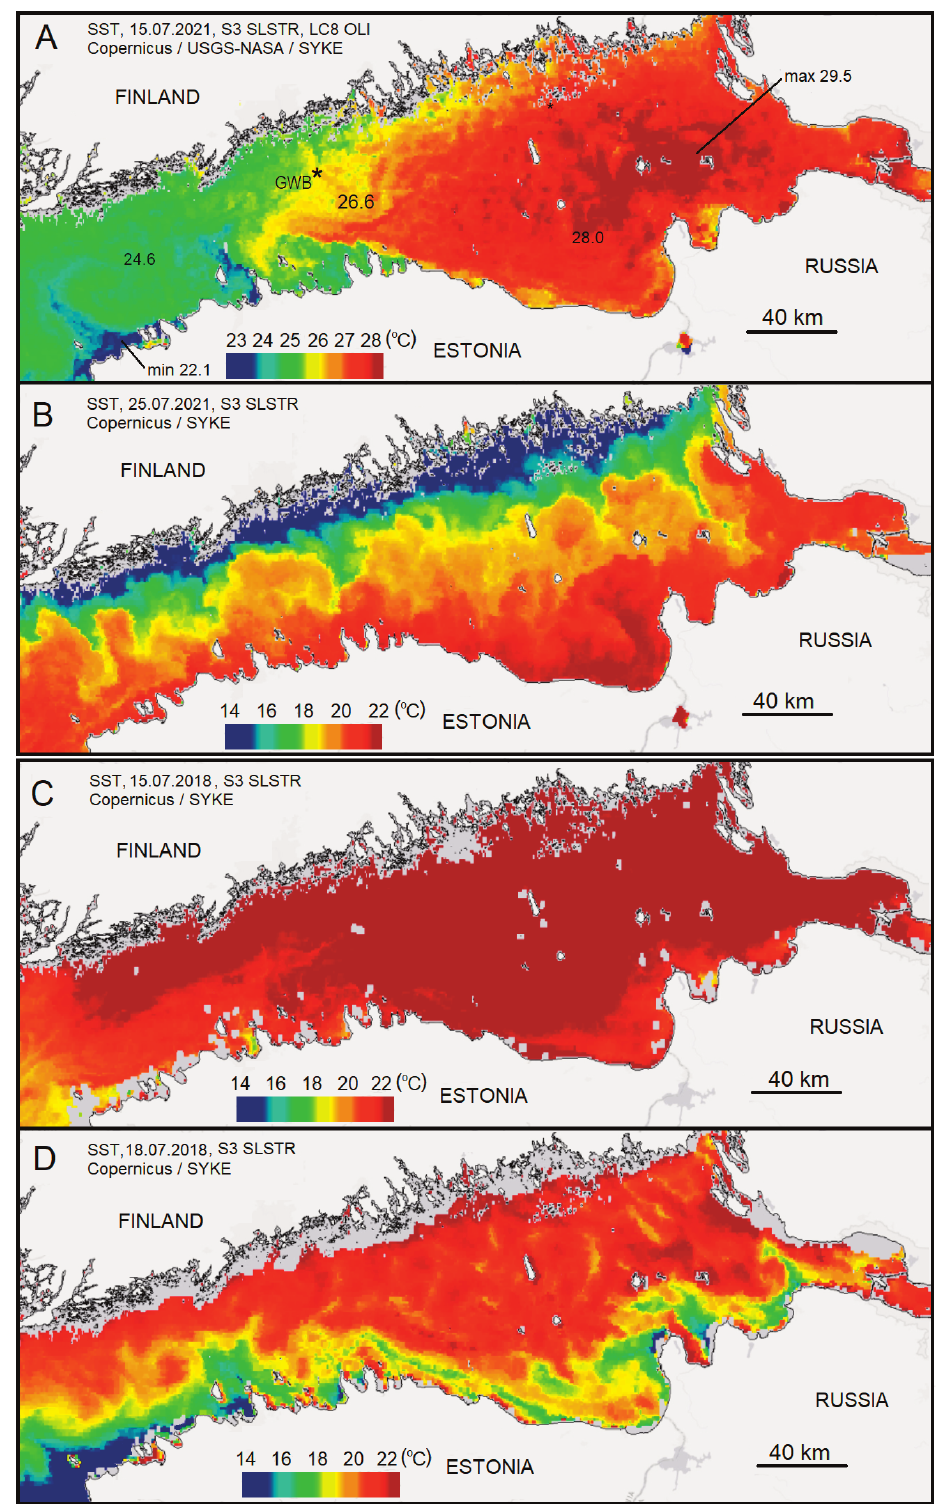
Fig. 7. SST images (modified from SYKE TARKKA) during the MHW peak in the Gulf of Finland on 15 July 2021 ( A ), subsequent CU at the Finnish coast on 25 July 2021 ( B ); MHW on July 2018 ( C ) and its erosion due to CU along the North Estonian coast ( D ). Note the different SST scales (e.g. 23–29 °C in A ). Grey areas on the sea are